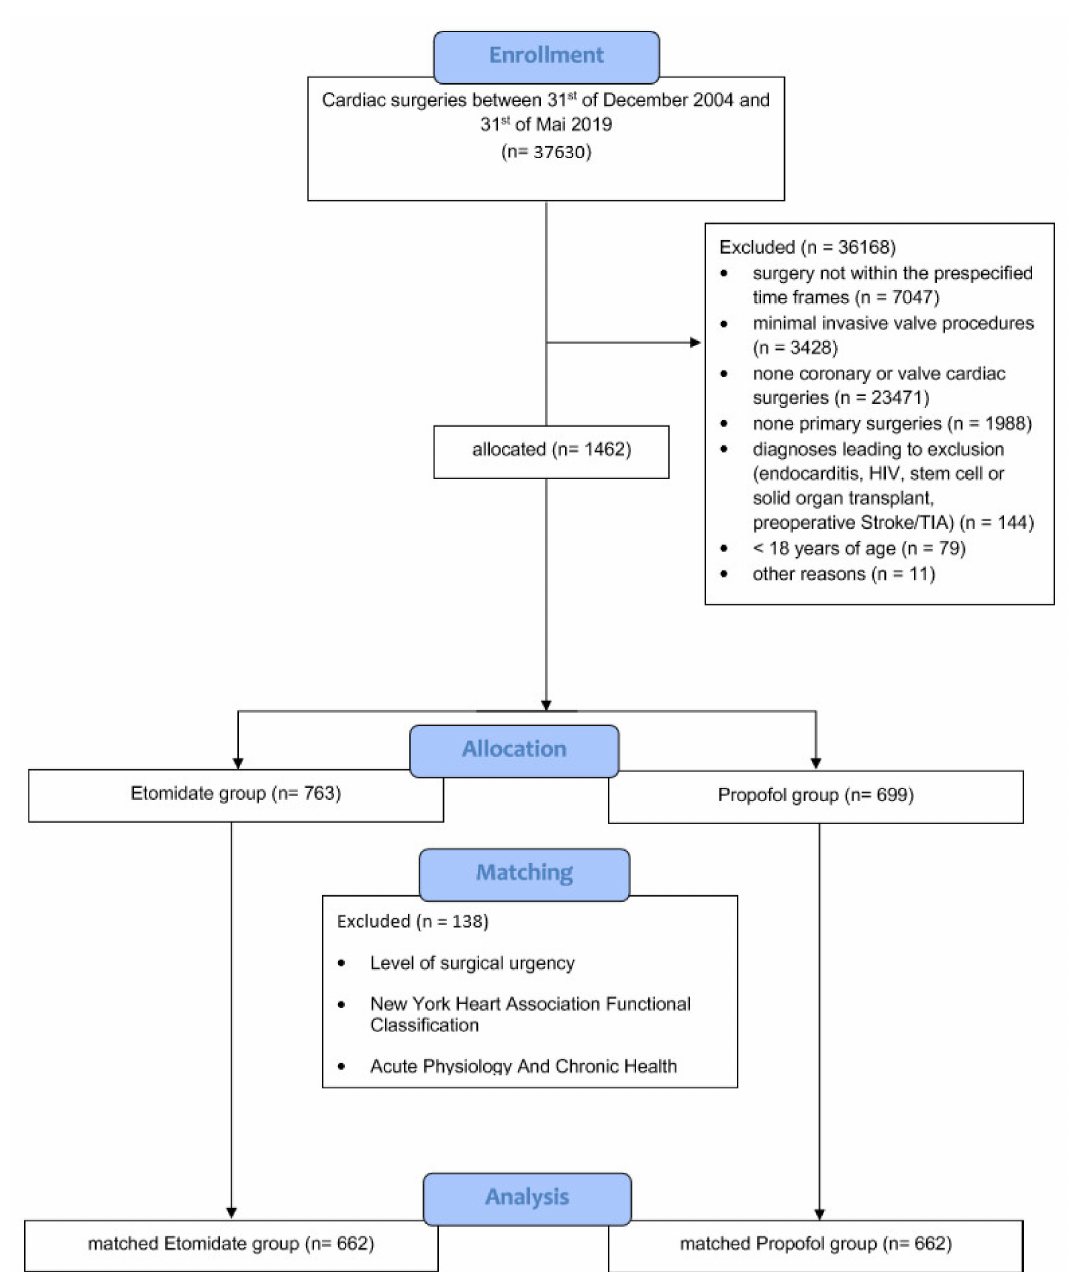
Figure 2. Study flow chart. A detailed visual description of the numbers of included and excluded